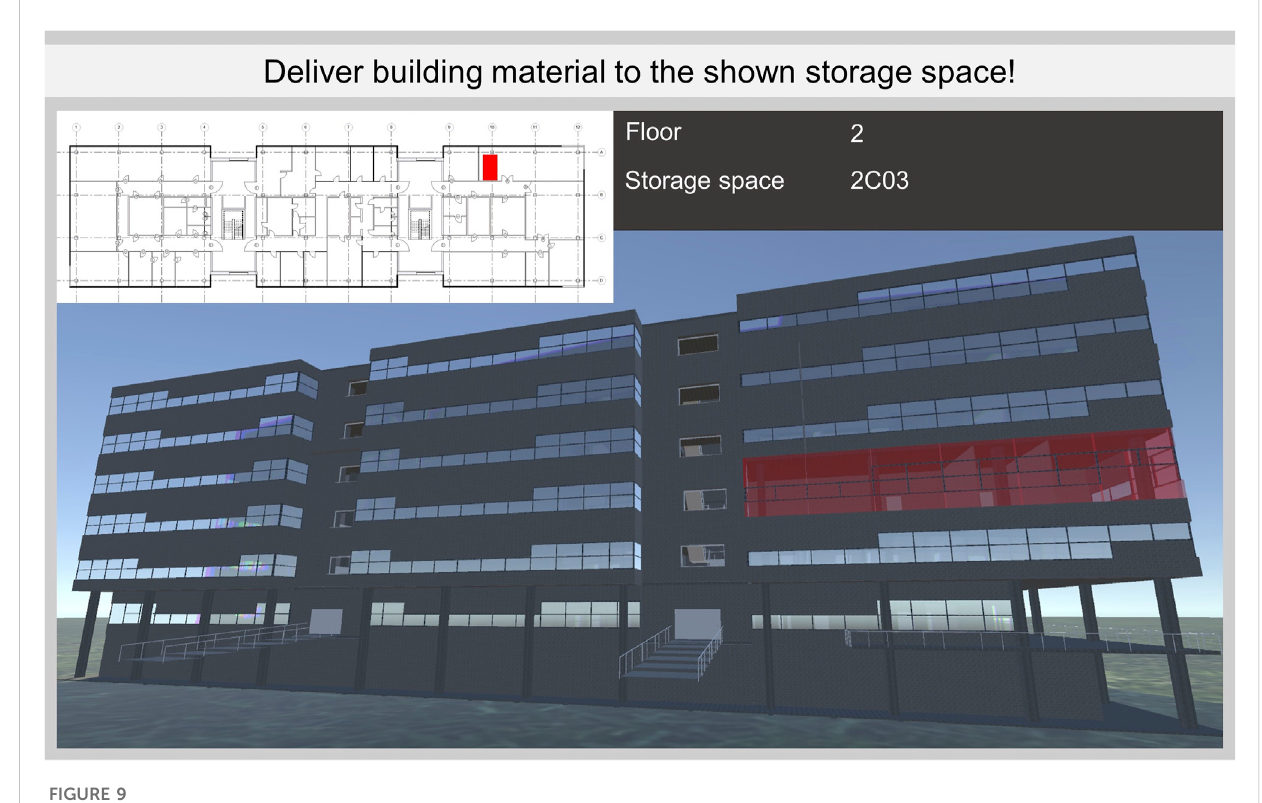
FIGURE 9 Visualization of a searched storage space based on the digital construction logistics